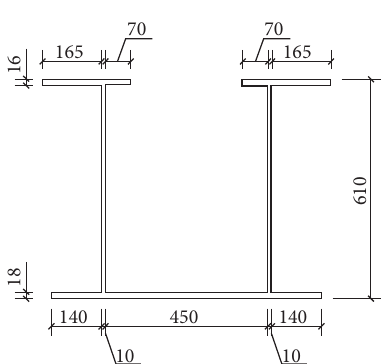
Figure 5: Diagramof across sectionof thesteel